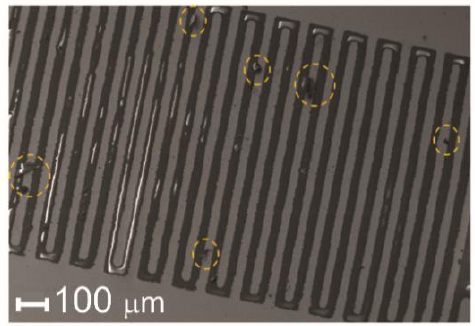
Figure 9. Scanning electron microscopy image of the electrode digit region. The yellow circles show small gaps in the conductive layer.